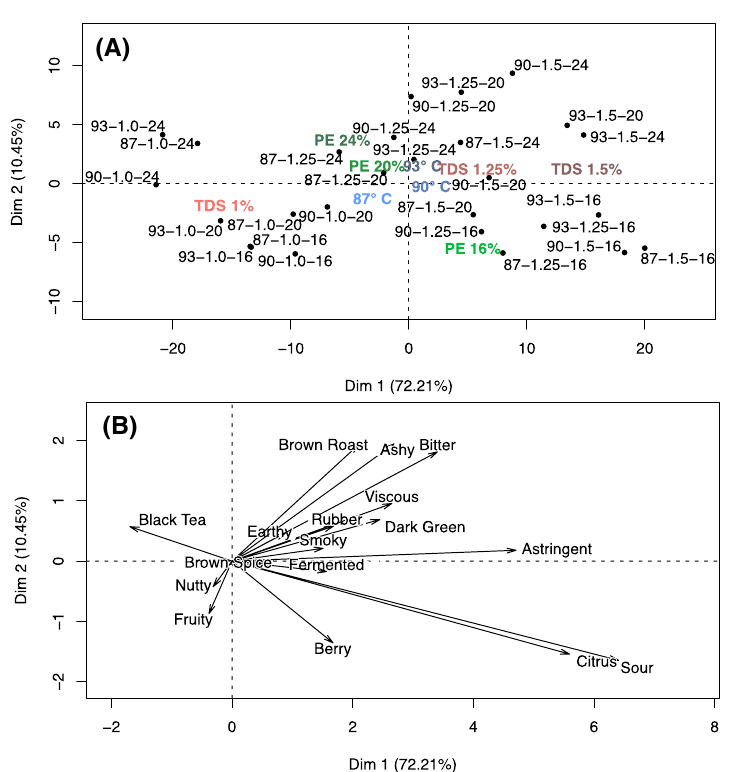
Figure 5. ( A ) Principal Component Analysis of individual brews, with each numerical code indicating the corresponding “temp–TDS–PE” combination of that brew. The independent variable means are also plotted and colour coded as follows: TDS, red; PE, green; and brewing temperature, blue; all are scaled from light to dark in accordance with variable magnitude. ( B ) Corresponding map of the attribute loadings for the dependent variables (sensory